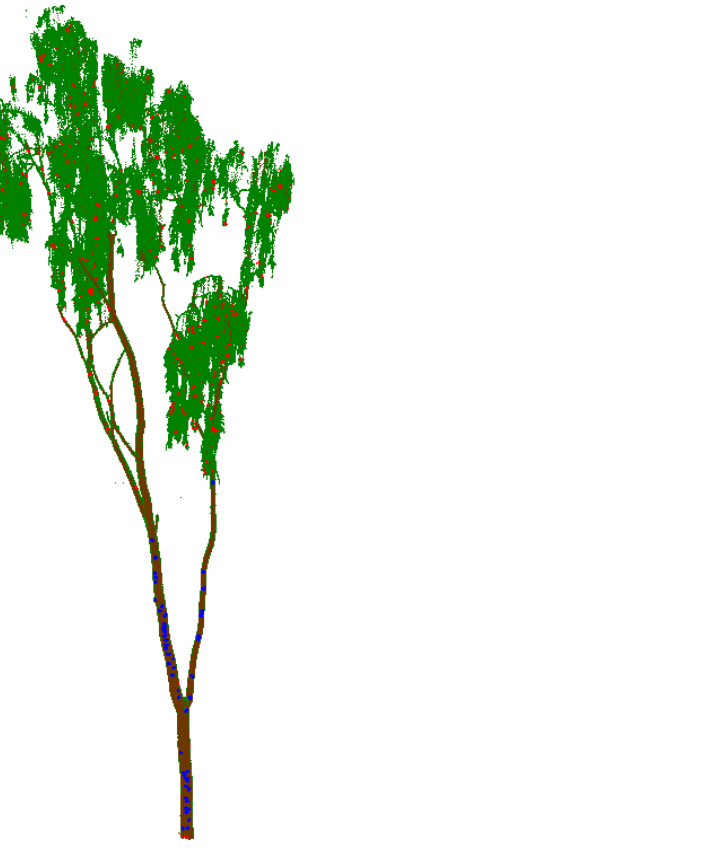
215 218 219 220 221 222 223 224 225 226 I , which is plotted in Figure 227 t